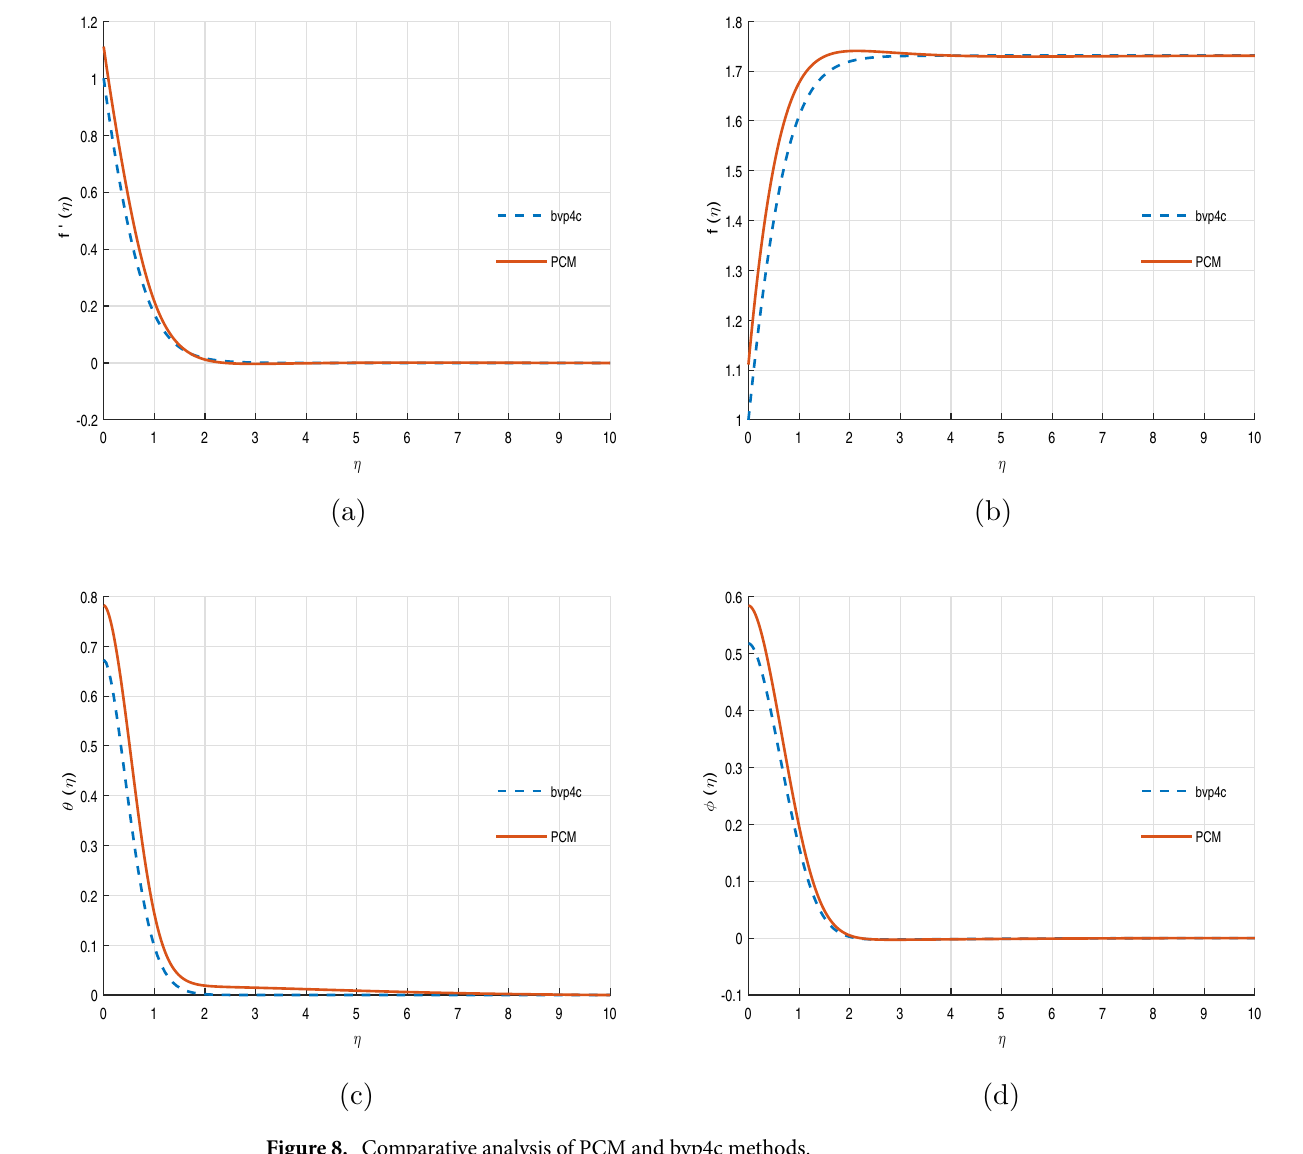
Figure 8. Comparative analysis of PCM and bvp4c